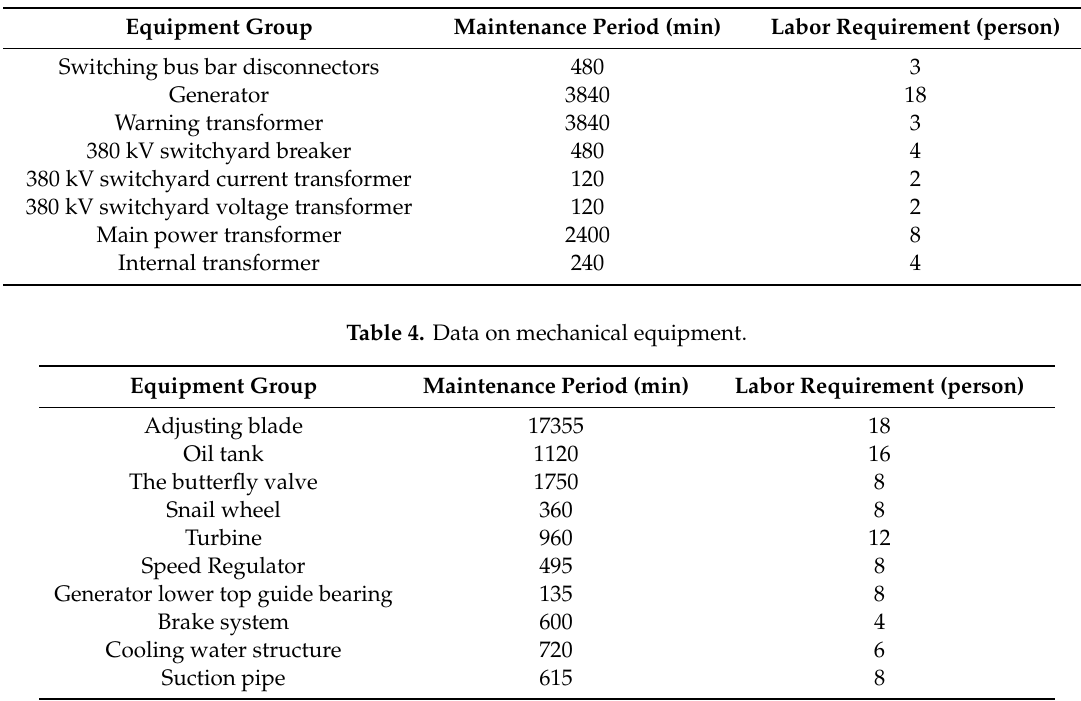
Table 3. Data of electrical equipment groups.